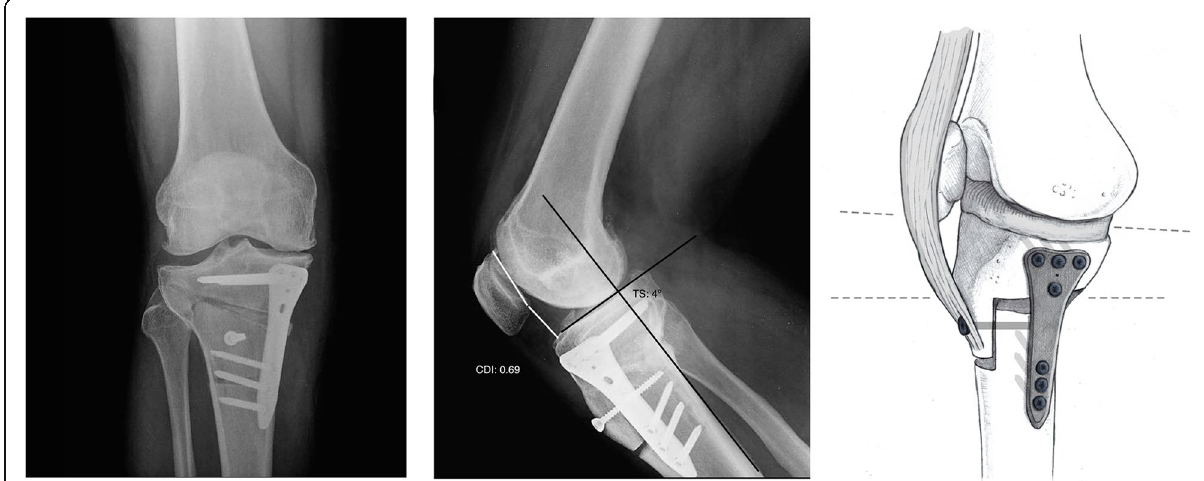
Fig. 4 Postoperative aspect, without significant modifications in patellar height or the posterior tibial